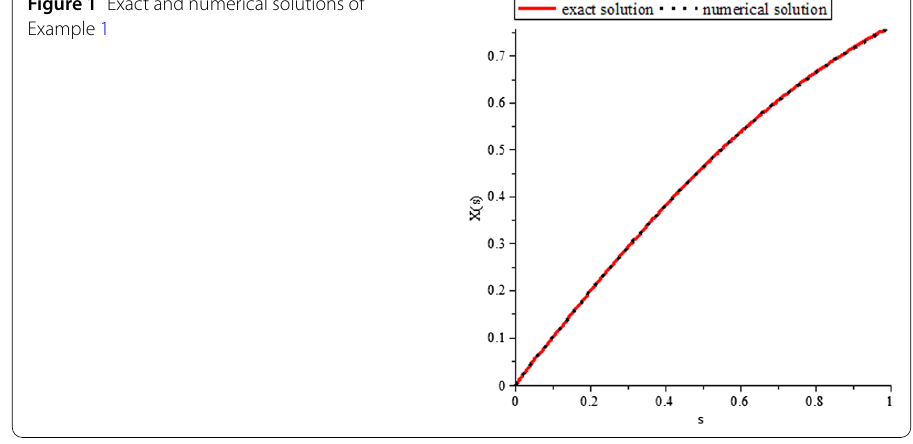
Figure 1 Exact and numerical solutions of Example 1